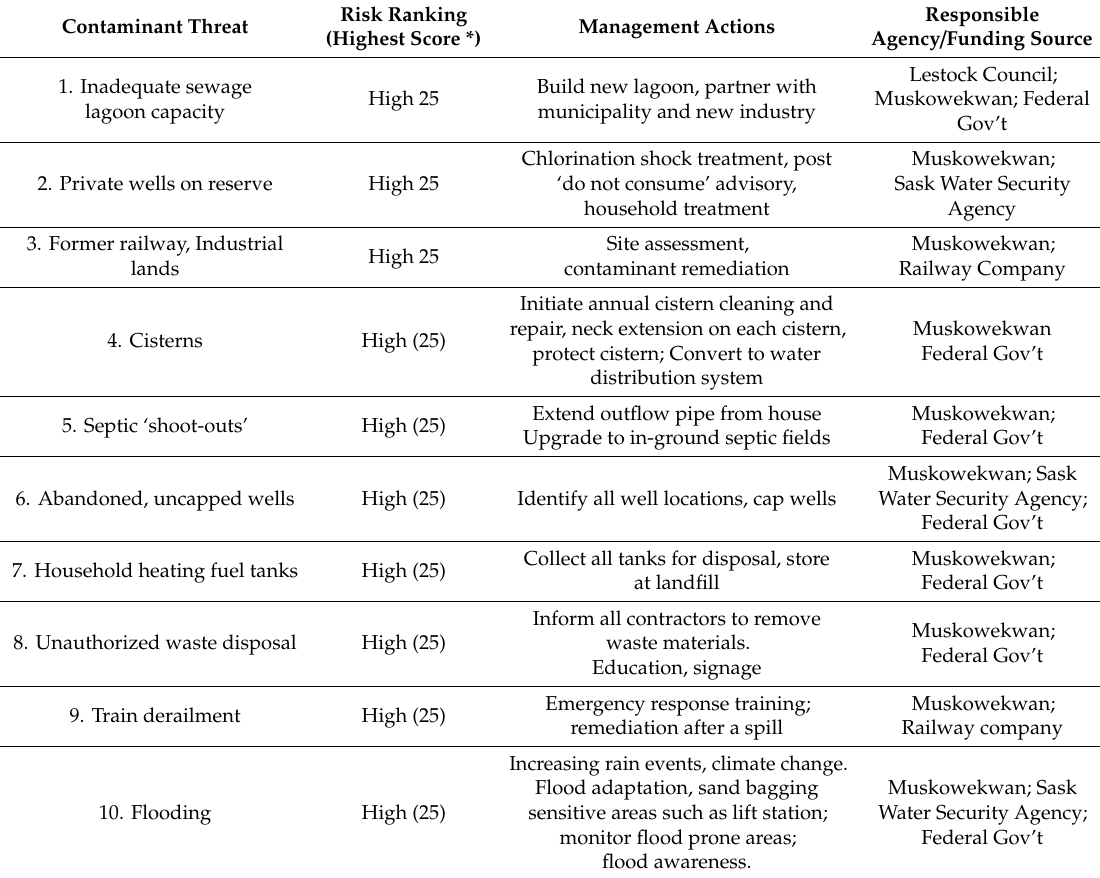
Table 2. Contaminant threat, management actions, and funding